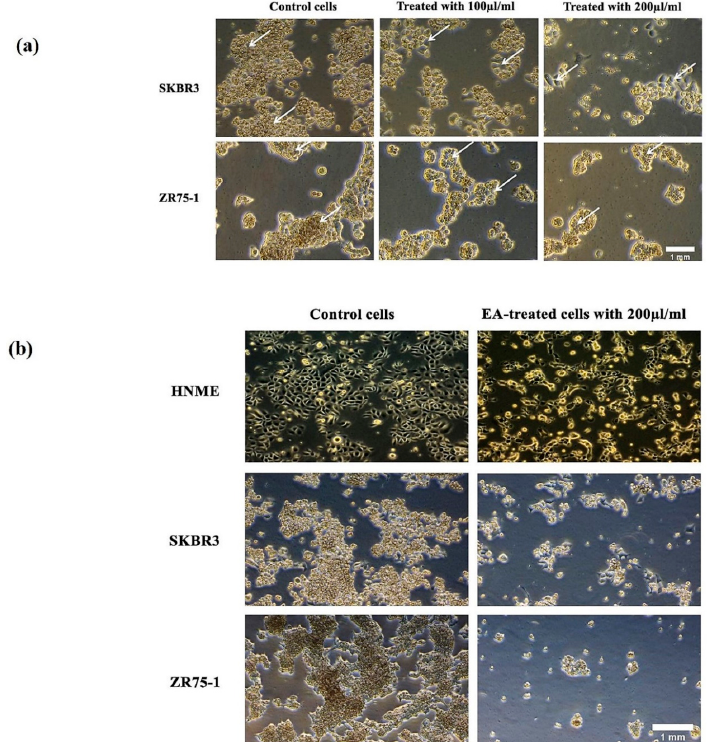
Figure 4. ( a , b ) EA plant extract induces morphological changes in HER2-positive cell lines, SKBR3 and ZR75- 1. ( a ) We observe that treatment for 48 h with 100 and 200 µL/mL of EA extract induces epithelial transition and the formation of a monolayer of cells in both cell lines, in comparison with untreated (control) cells which display a round phenotype and form multilayers; arrows indicate epithelial morphology with clear cell-cell adhesion. ( b ) At three days of treatment of SKBR3, ZR75-1, and HNME-E6/E7 cell lines with 200 µL/mL of EA plant extract, the two cancer cell lines start detaching from the surface of the tissue culture dish, indicating cell death; this observation was not noted in the HNME-E6/E7 cells (images a and b at ×20 magnification). These results imply that moderate concentrations of 100 µL/mL of EA plant extract induce cell differentiation after 24 and/or 48 h, while higher concentrations (200 µL/mL of EA plant extract) can provoke apoptosis after 48 h of exposure.